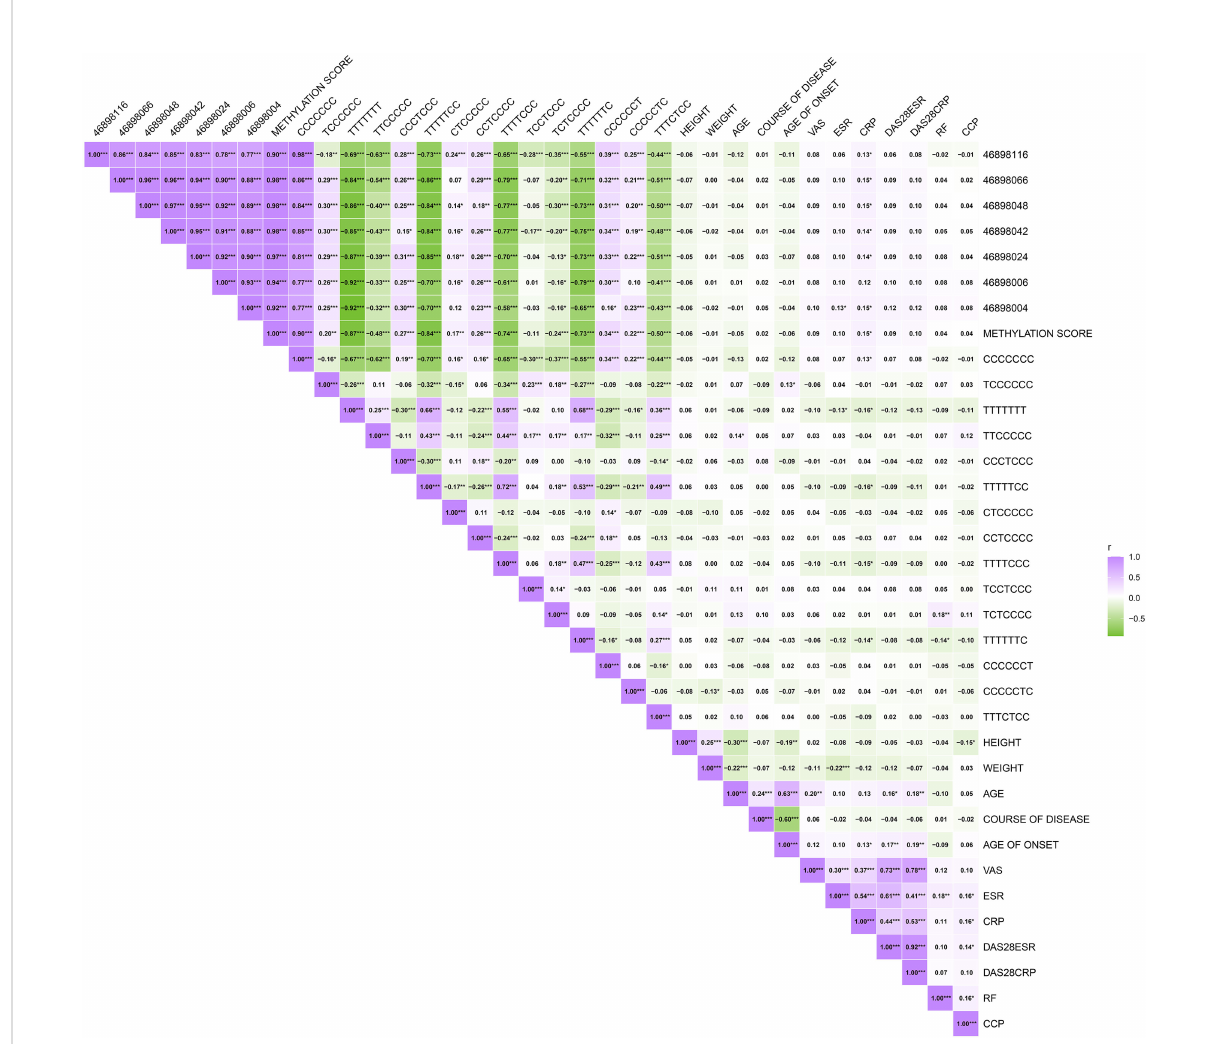
FIGURE 2 The correlation of CpGs sites and different haplotypes with interclinical indicator. Correlation plots were used to observe the correlations. *** P < 0.001, ** P < 0.01, * P <